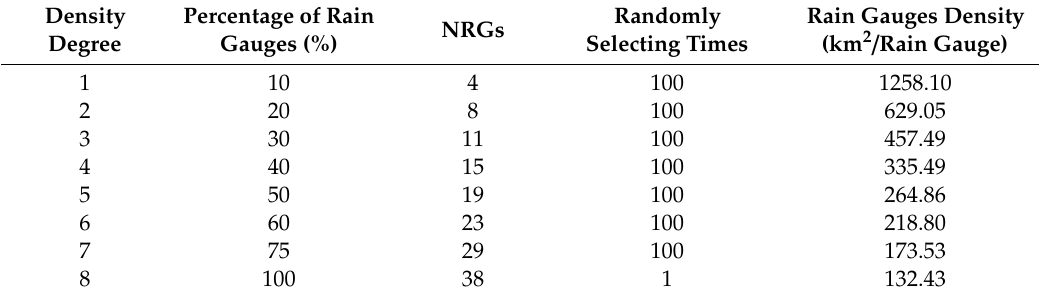
Table 1. Number of rain gauges in di ff erent